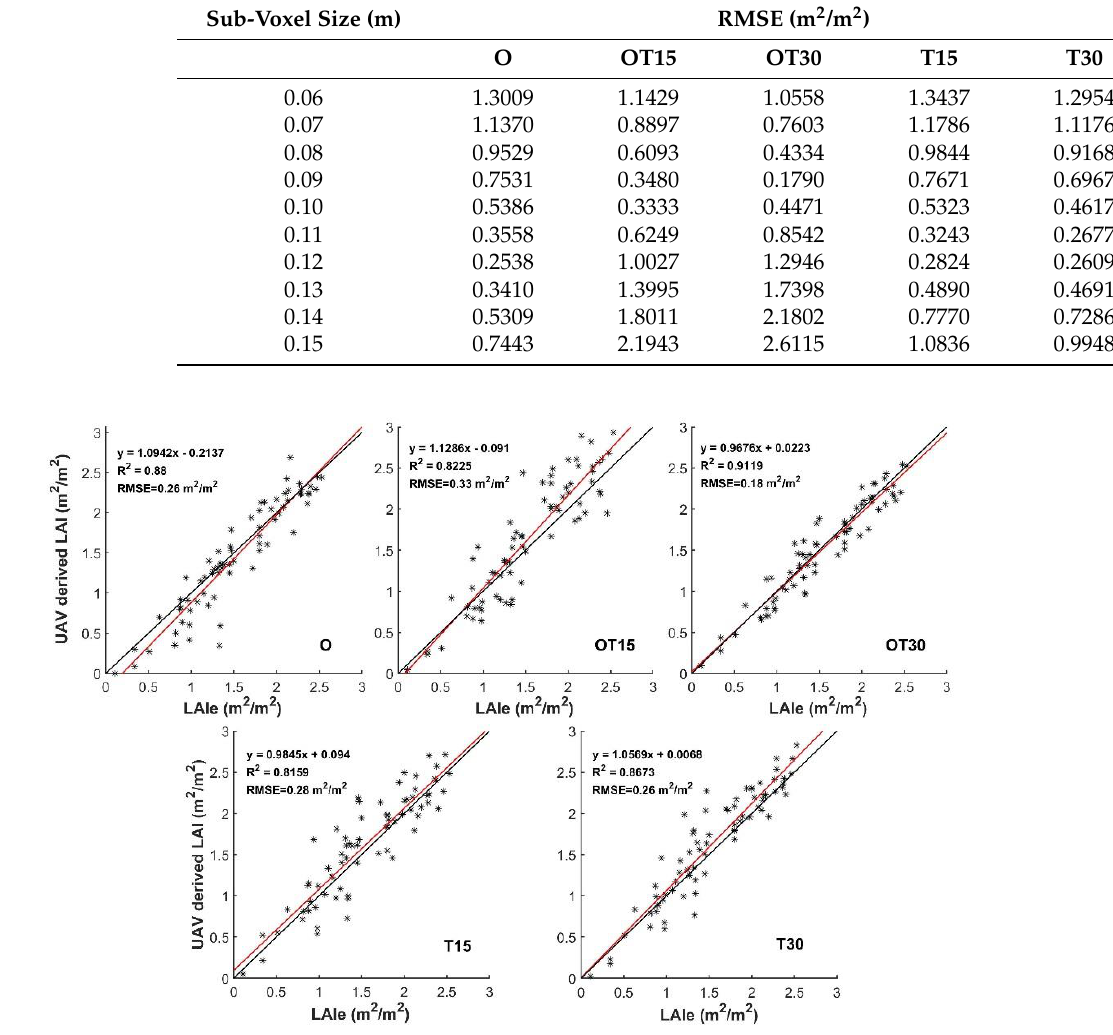
Figure 9. The best LAI estimation scheme for each of the five schemes, under different sub-voxel sizes. Sub-voxel size when the LAI of the five schemes was the best: O (0.12 m); OT15 (0.10 m); OT30 (0.09 m); T15 (0.12 m); T30 (0.12 m).